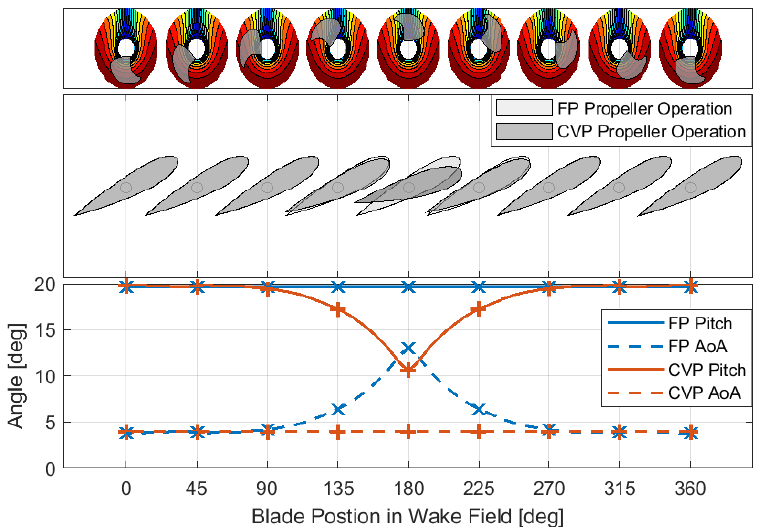
Figure 2. Illustration of the operation principle of the CVP propeller. Reproduced from [1] with permission from the authors. AoA is an abbreviation for angle of